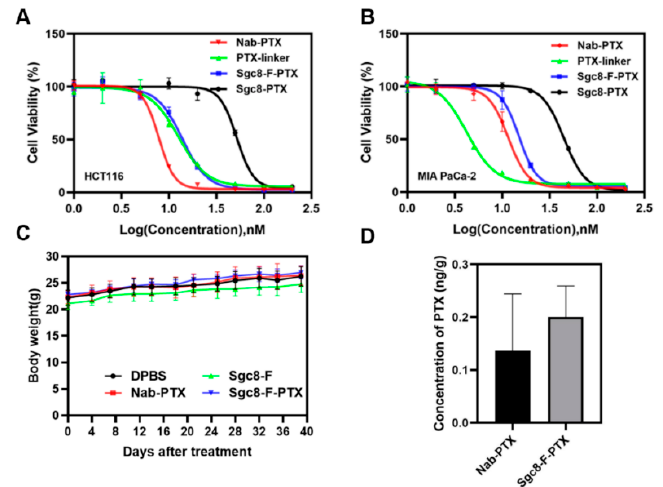
Figure 4. ( A ) Proliferation–inhibitory effects against HCT116 cells and ( B ) MIA PaCa-2 cells; cells were incubated with drugs at different concentrations for 72 h and analyzed with CCK-8 assay, and data were presented as the means ± standard deviation, n = 3. ( C ) Body weight of MIA PaCa-2 tumor-bearing mice with different treatments. ( D ) PTX concentration analysis of Nab-PTX- or Sgc8-F- PTX-treated mice; PTX was extracted from the tumor tissue and analyzed with